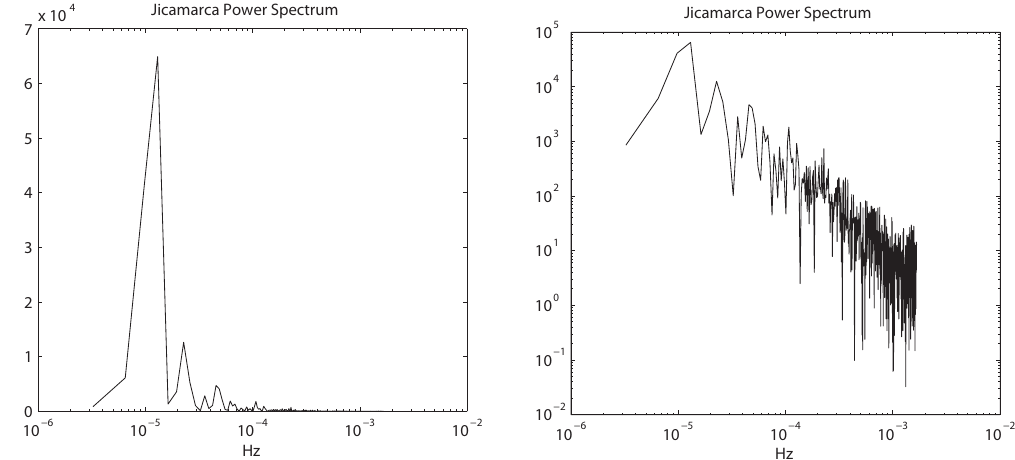
Fig. 3. Linear-log and log-log depictions of the Jicamarca data set. We are only interested in frequencies between 2 × 10 − 5 Hz and 2 × 10 − 4 Hz.